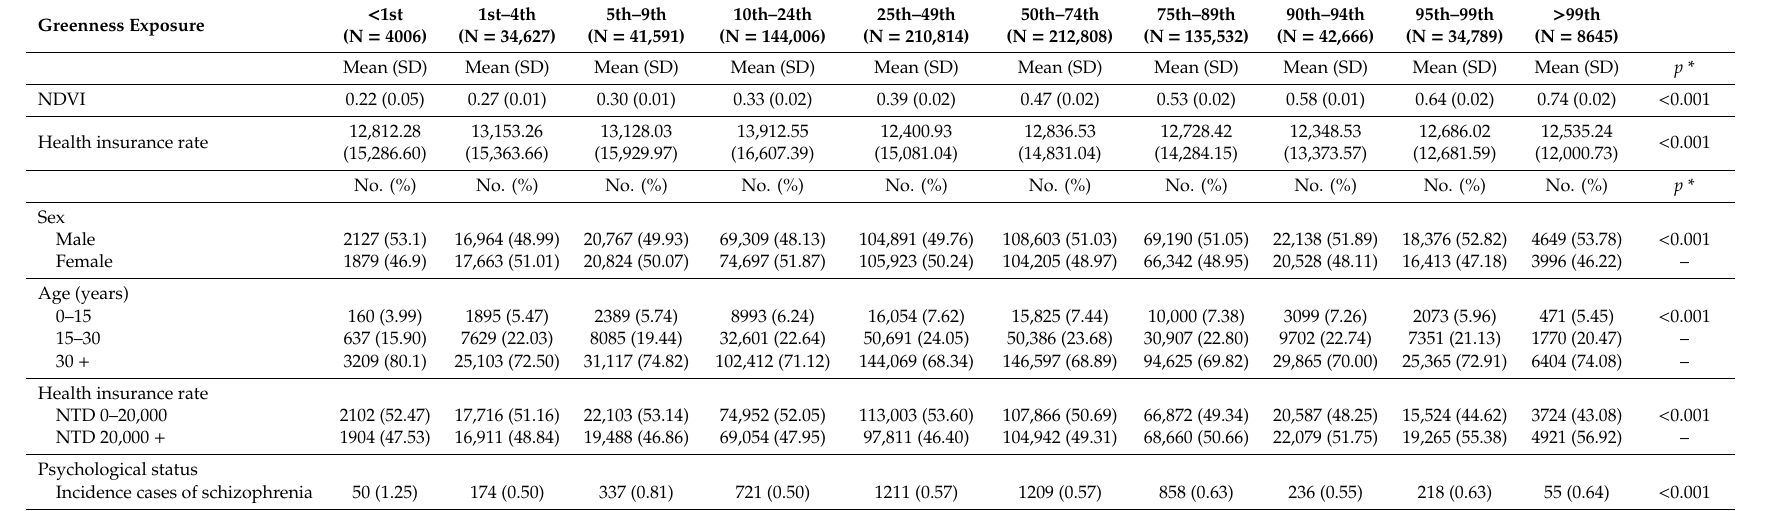
Table 1. Baseline characteristics of study population stratified by greenness exposure (N =